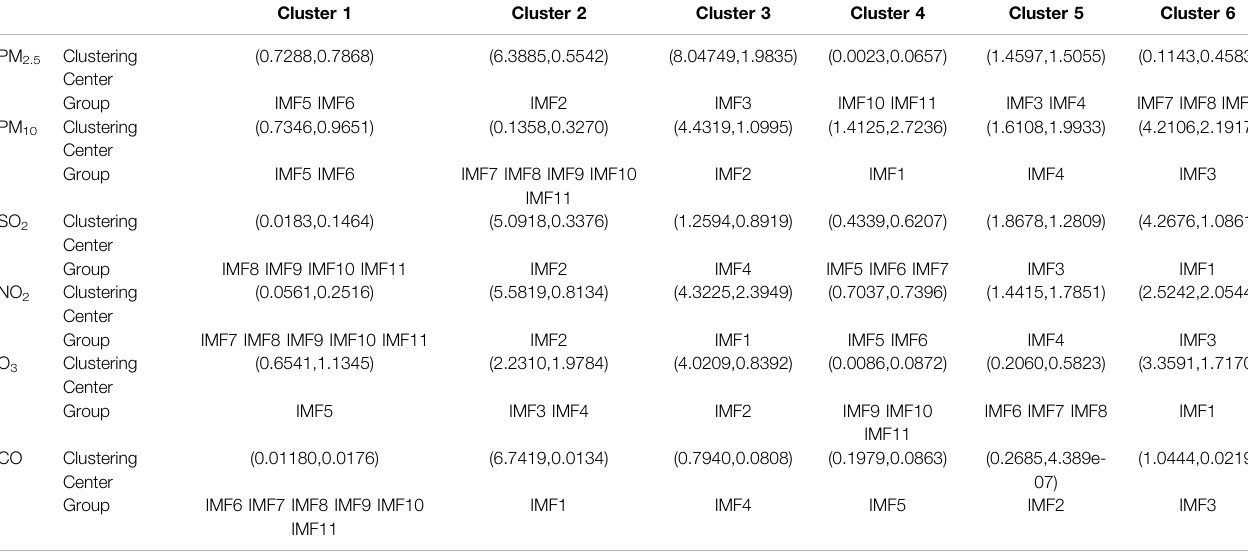
TABLE 3 | Clustering centers and groupings of each pollutant by K-means.